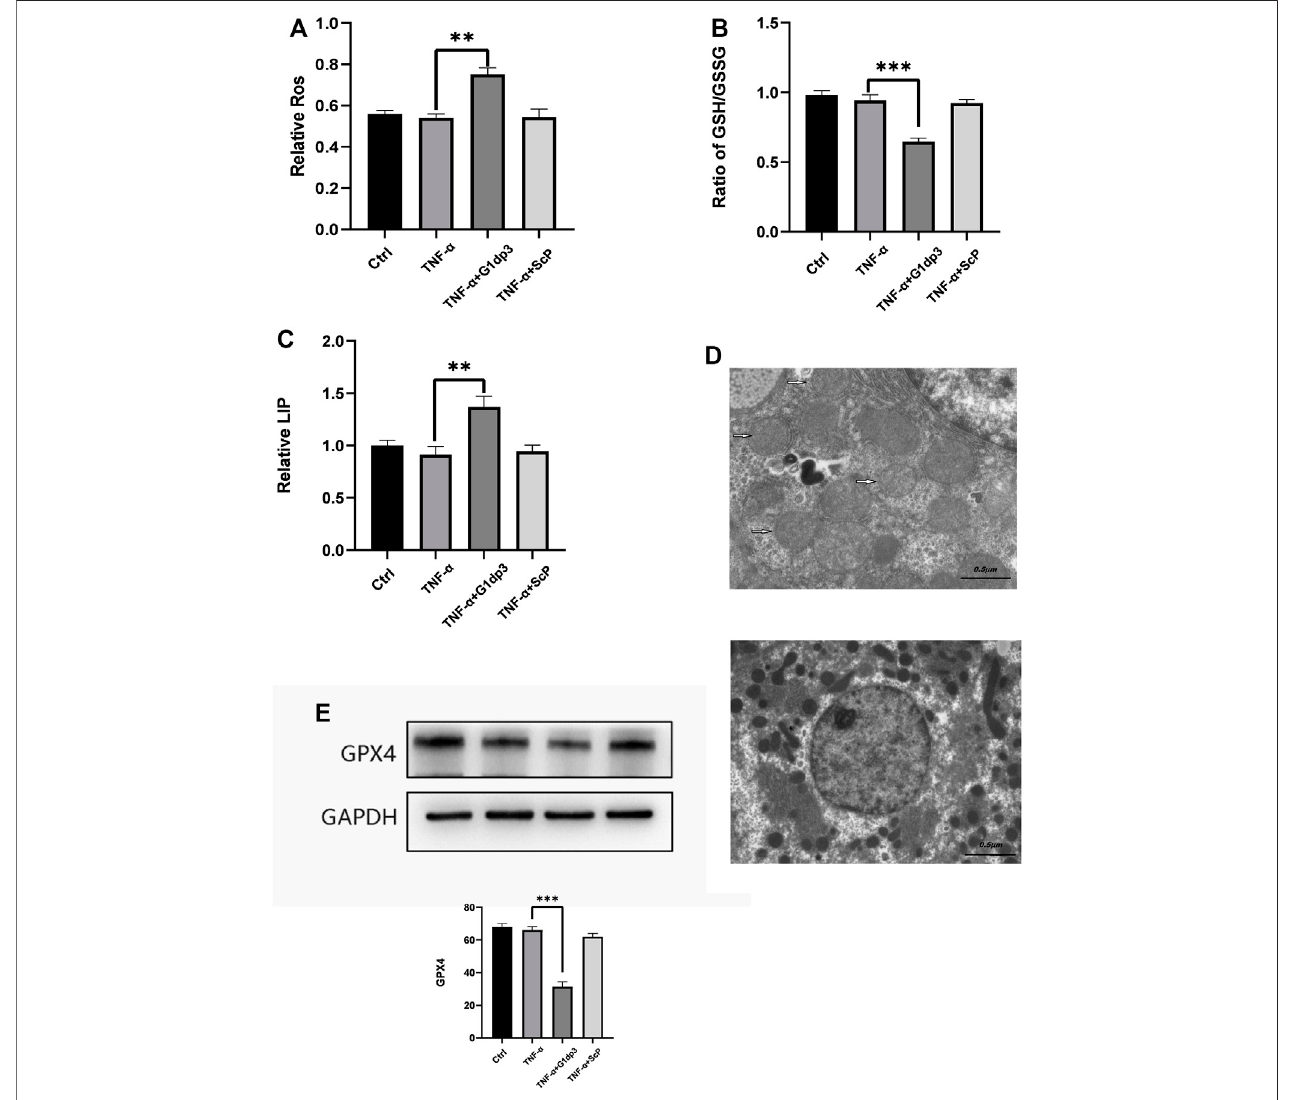
FIGURE 2 | The inhibitory effect of G1dP3 on MH7A cell viability is correlated with ferroptosis (A) Relative lipid peroxidation levels in the indicated MH7A cells assessed by BODIPY 581/591 C11. G1dP3 (20 μ M, 6 h) could increase the accumulation of lipid ROS. (B) Ratio of GSH/GSSG in the indicated MH7A cells. G1dP3 reduced the ratio of GSH/GSSG. (C) Relative cellular labile iron pool (LIP). G1dP3 could signi fi cantly increase free iron levels in MH7A cells. (D) Representative TEM images illustrating that G1dP3 alters mitochondrial morphology in MH7A cells. Scale bars are displayed in each image. (E) The protein expression of Gpx4. Graph represents mean ± SD; * p < 0.05, ** p < 0.01, *** p < 0.001, ns, not signi fi cant. Representative data from one of three individual experiments.